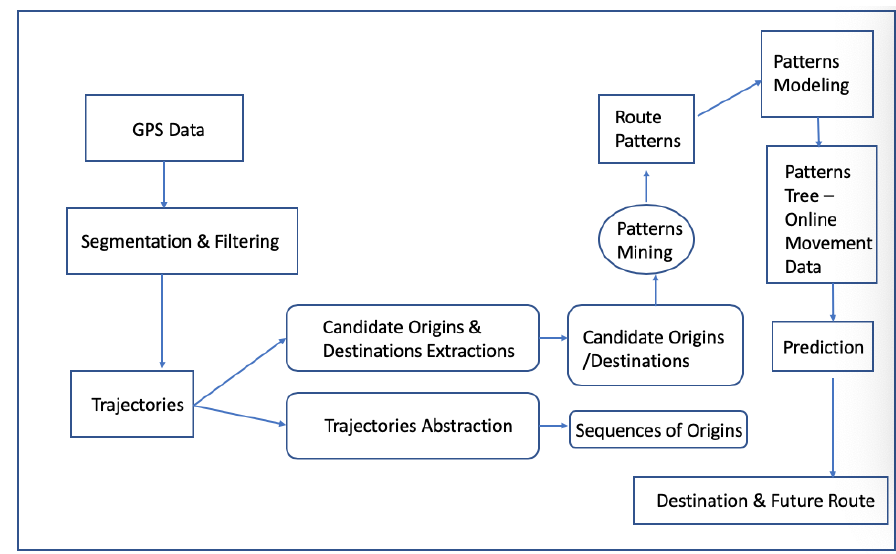
Figure 13. A prediction system architecture presented in Reference [52].